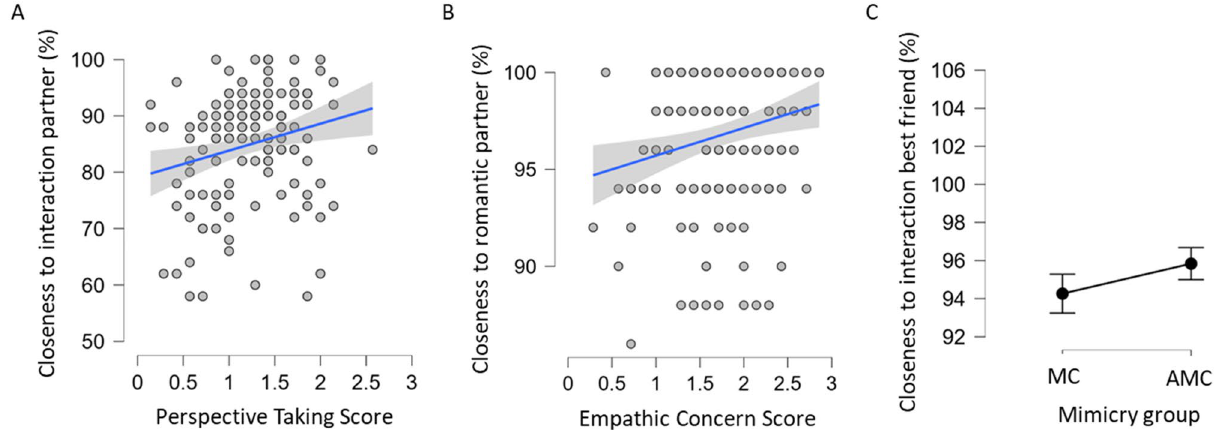
Figure 1. ( A–C) Experienced social closeness to interaction partner (confederate), best friend and romantic partner in percent (%). Percentage of experienced closeness to ( A ) interaction partner, ( B ) romantic partner in relation to individual EC Score; ( C ) best friend in relation to Mimicry group (mimicry/anti-mimicry condition); Shaded area ( A , B ), error bars ( C ): credible interval